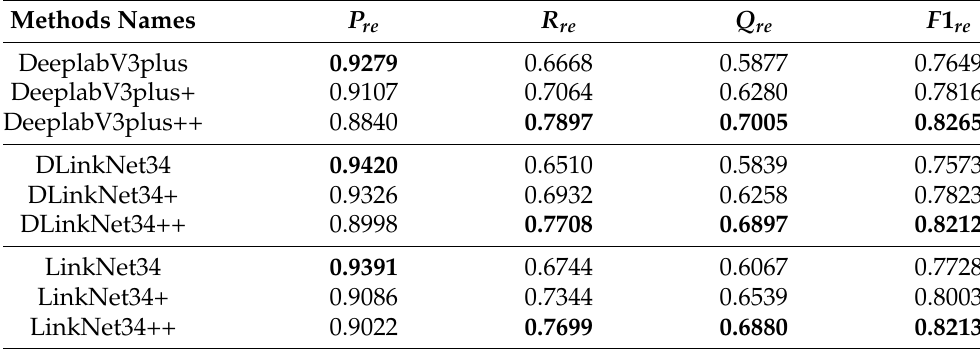
Table 5. Comparative quantitative Evaluation among Different Methods for Road Extraction on our dataset. With the best results marked in bold. α = 2, β = 1.